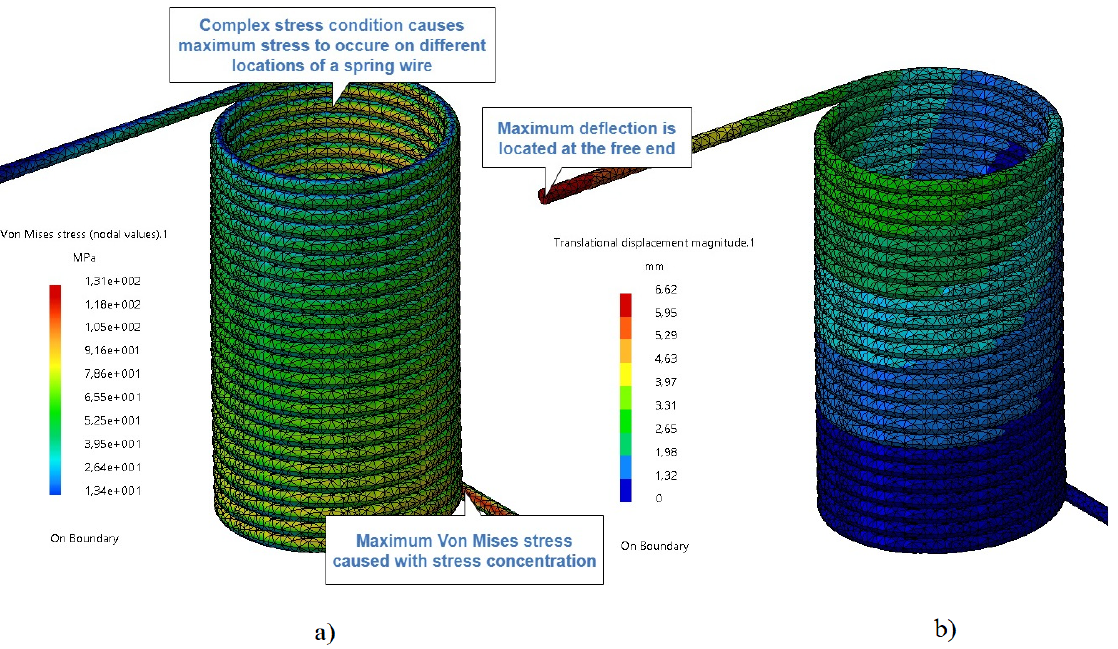
◦ end type torsion spring FEM analysis results. ( a ): Von Mises stress, ( b ): Figure 8. 90 0 end type torsion spring FEM analysis results. ( a ): Von Mises stress, ( b ): Displacement. Figure 8. 90